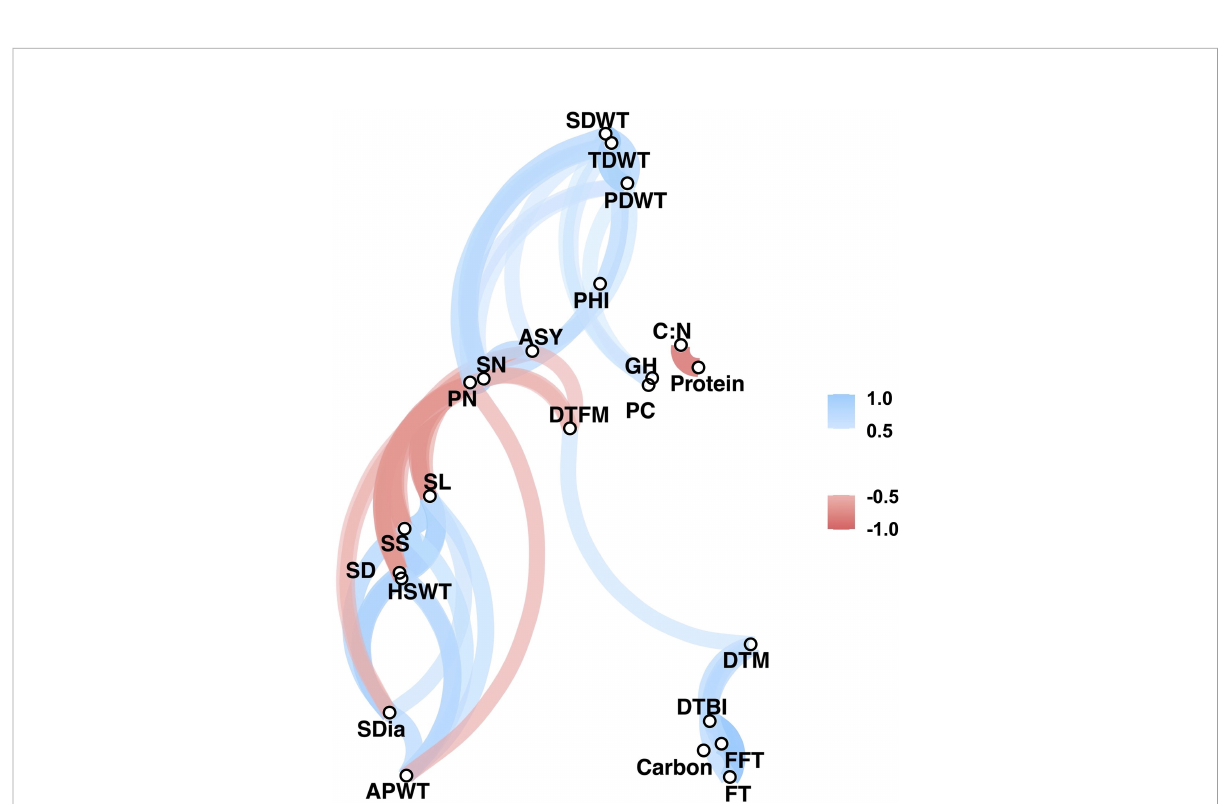
FIGURE 3 Correlation network plot for all phenotypic traits above r= 0.5. See Table 1 for trait